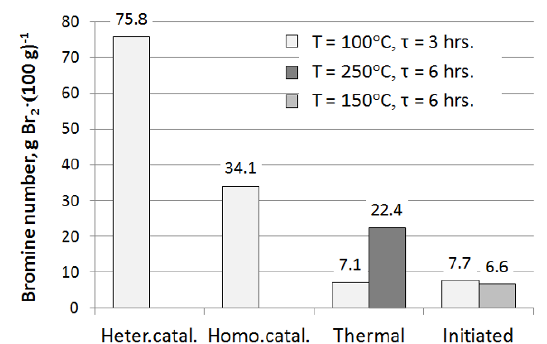
Figure 6. Unsaturation of the cooligomers synthesized by different methods.